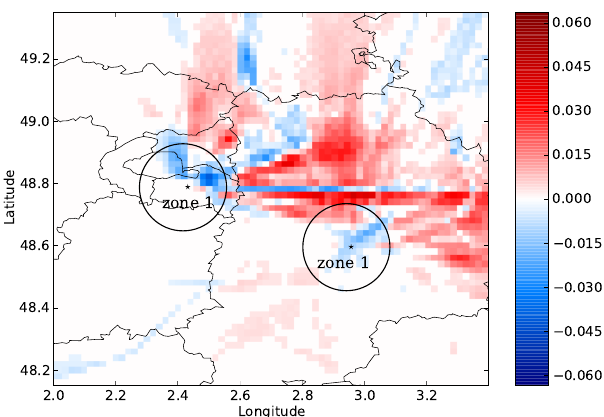
Fig. 7. Differences (PinG – PinG-SizeOnly) in mean surface con- centrations of NO x for 4–29 July 2009 over the Greater Paris do- main